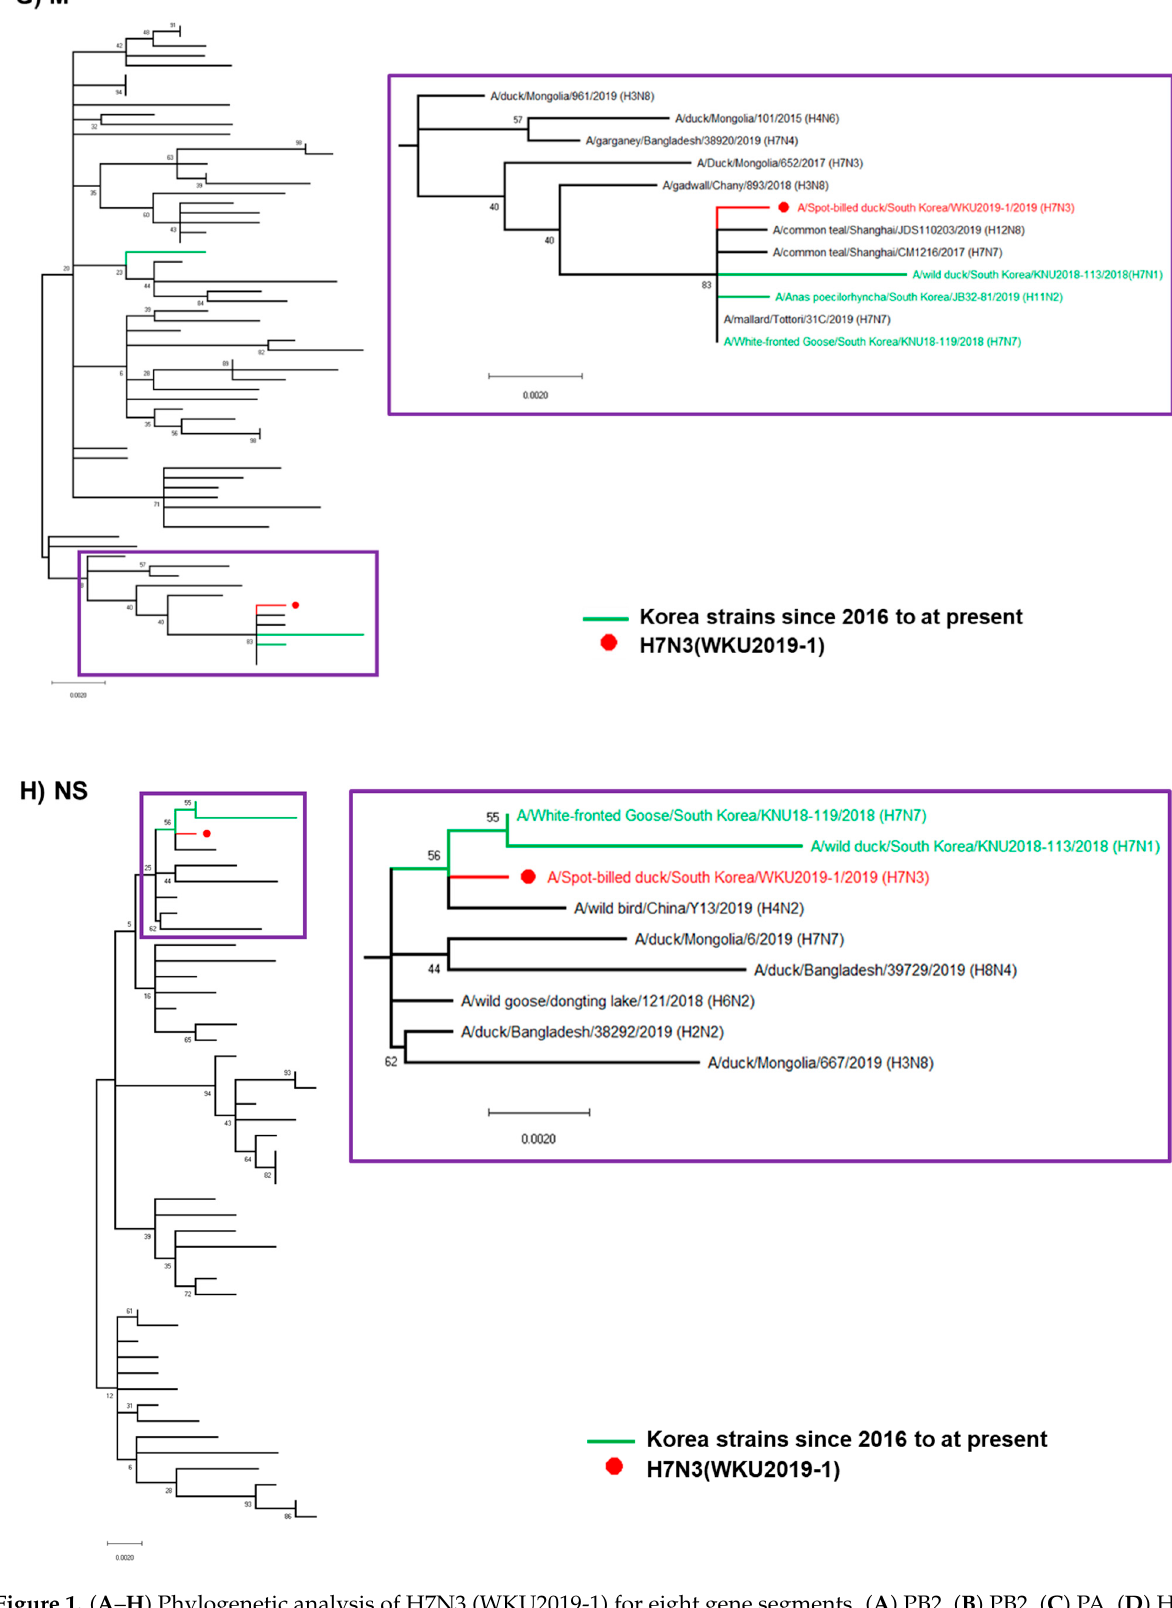
Figure 1. ( A – H ) Phylogenetic analysis of H7N3 (WKU2019-1) for eight gene segments. ( A ) PB2, ( B ) PB2, ( C ) PA, ( D ) HA, ( E ) NP, ( F ) NA, ( G ) M, ( H ) NS. (PB—polymerase basic protein; NP—nucleoprotein; HA—hemagglutinin; PA—polymerase acidic protein; NA—neuraminidase; M—matrix protein; NS—non-structural